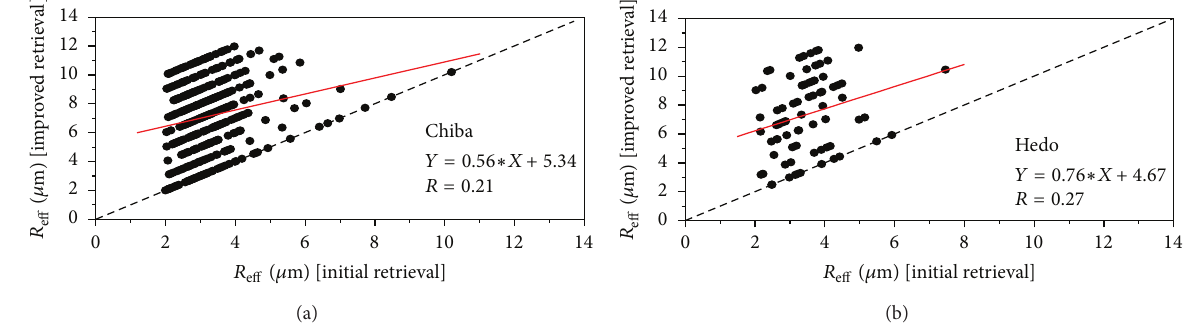
Figure 5: Initial and improved retrievals of cloud droplet effective radius over (a) Chiba and (b) Cape Hedo.